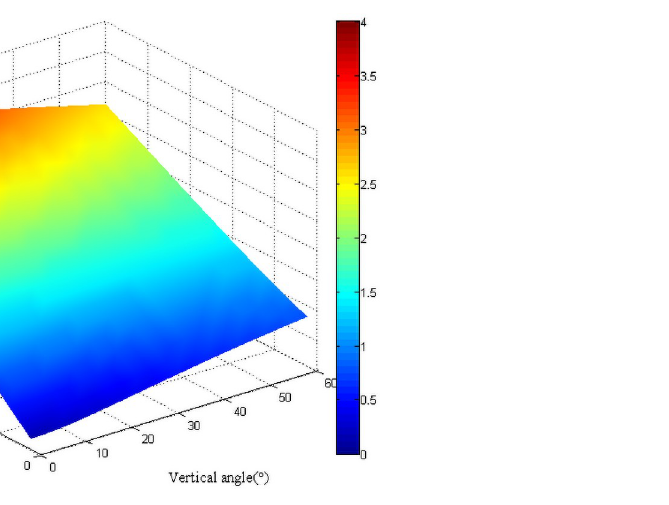
Fig 7. Vertical displacement accuracy with trigonometric